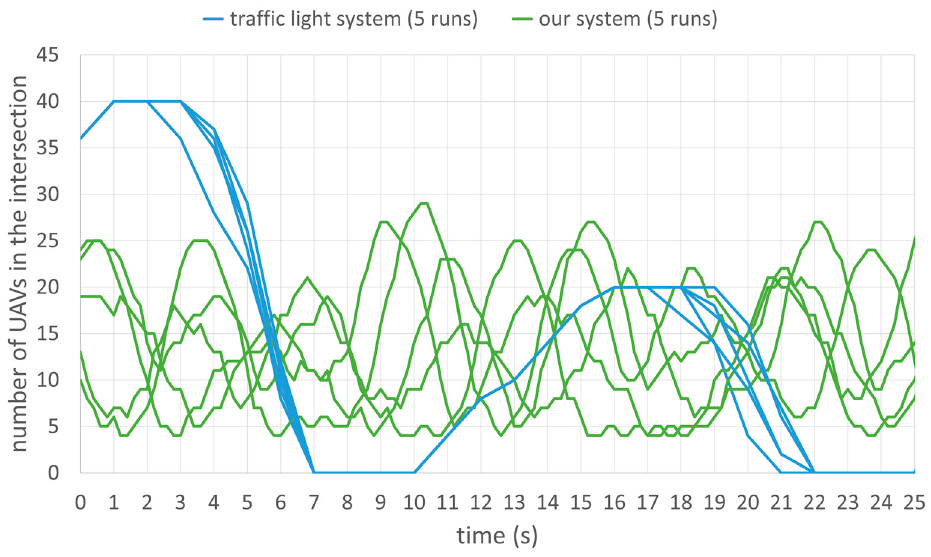
Figure 30. Number of UAVs in the intersection for Scenario 2 when arrival rate is 50 UAVs per minute.